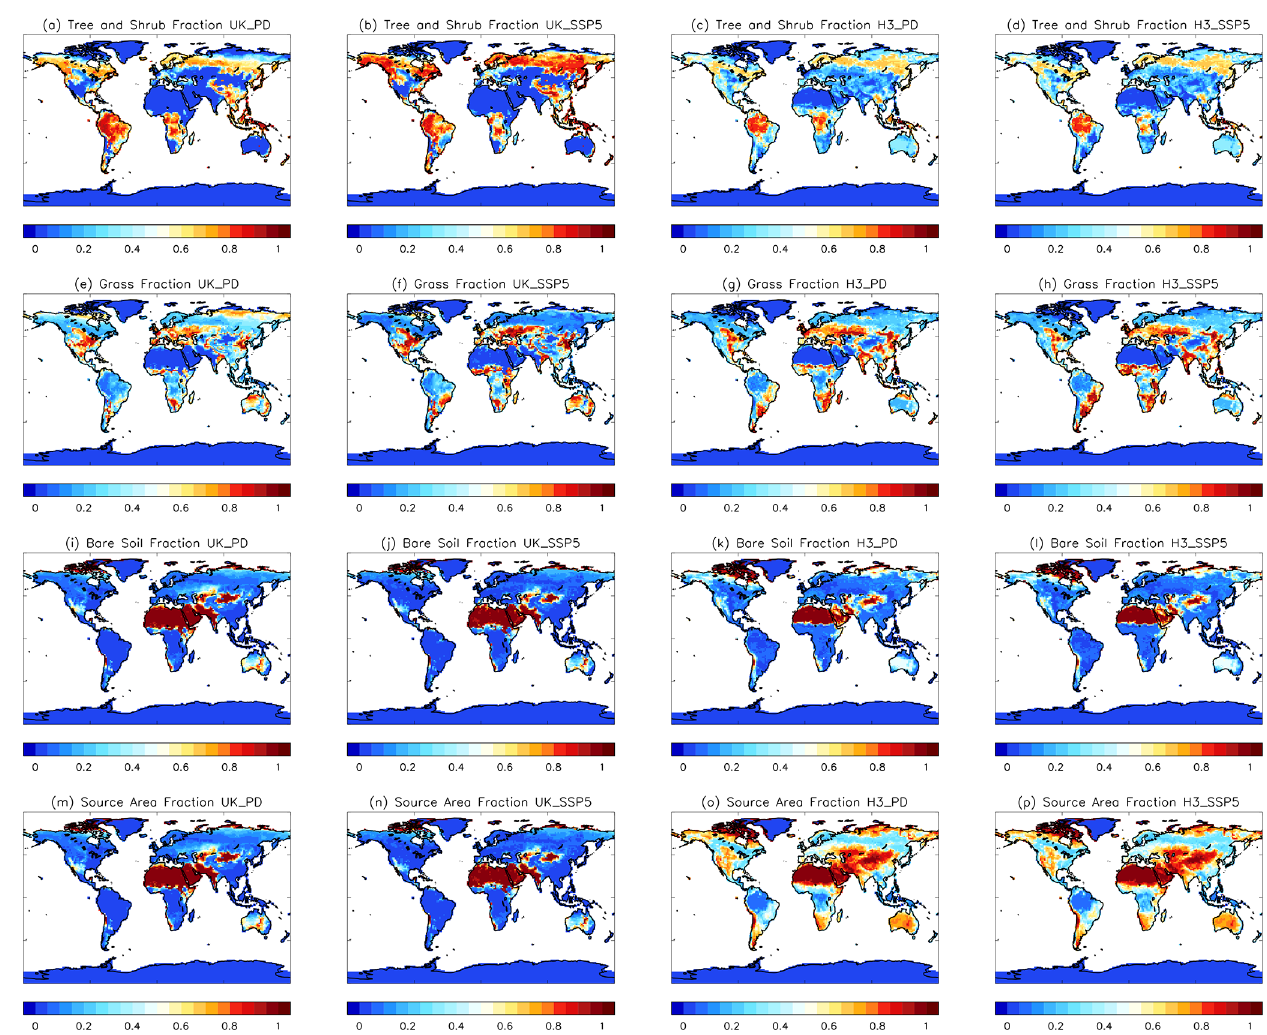
Figure 10. Grass fraction, tree and shrub fraction, bare soil fraction and dust source area fraction from UK_PD, UK_SSP5, H3_PD and H3_SSP5. (The H3_PD and H3_SSP5 source areas include seasonal sources.)